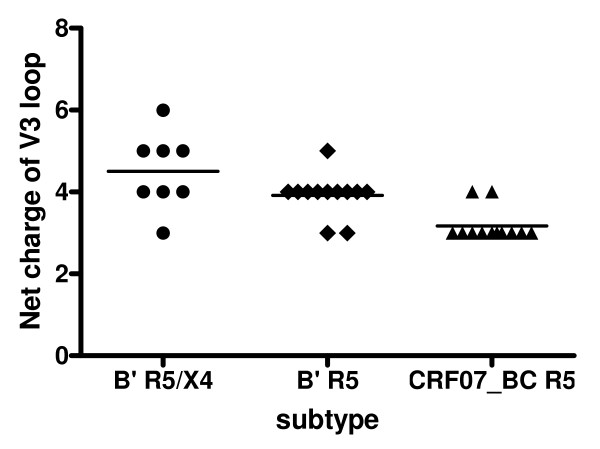
Comparison of the net charge of V3 loops between CRF07_BC and subtype B' viruses. The net charge of the V3 loop of CRF07_BC virus (3.17 ± 0.39) is significantly lower than both of the subtype B' R5/X4 virus (4.5 ± 0.93, P = 0.0003) and subtype B' R5 virus (3.92 ± 0.51, P = 0.0006), but there is no difference of the net charge of the V3 loop between subtype B' R5/X4 and R5 group.